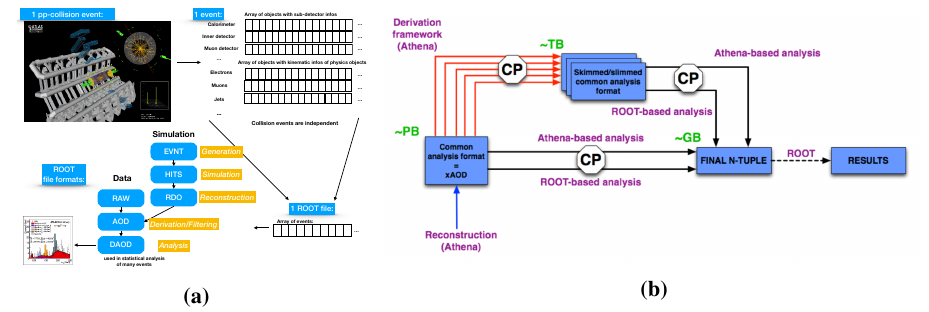
Figure 1: (a) The computing workflows in the ATLAS experiment. (b) The ATLAS Run-2 analysis